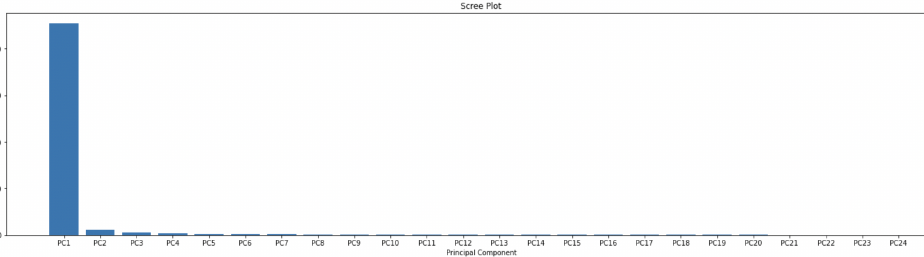
Figure 18. Scree plot of the cancer patients